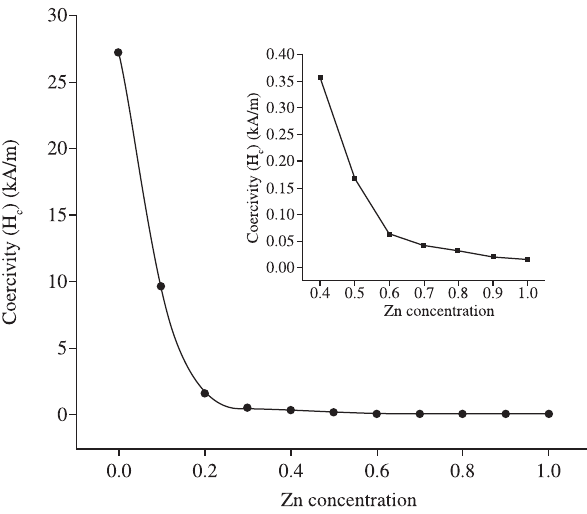
Figure 7. Variation of coercivity with Zn concentration for Ni x varying from 0 to 1.0 (Inset: Variation of coercivity with Zn concentration for Ni Zn Fe2O4 with x varying from 0.4 to 1.0.) 1-x x